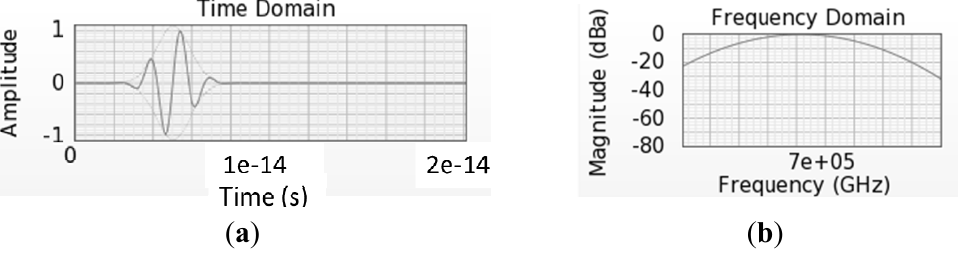
Figure 11. Time-based E -fields introduced as a plane wave ( a ) to simulate a range of frequencies ( b